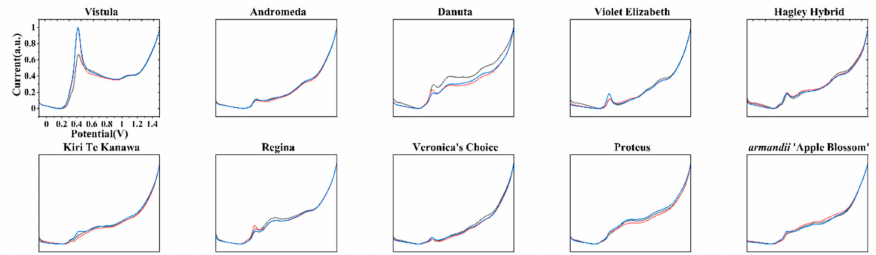
Figure 3. DPV curves of Vistula, Andromeda, Danuta, Armandii ‘Apple Blossom,’ Proteus, Hagley Hybrid, Violet Elizabeth, Kiri Te Kanawa, Regina, and Veronica’s Choice recorded in a 0.1 M acetate bu ff er (ABS) after ethanol extraction.